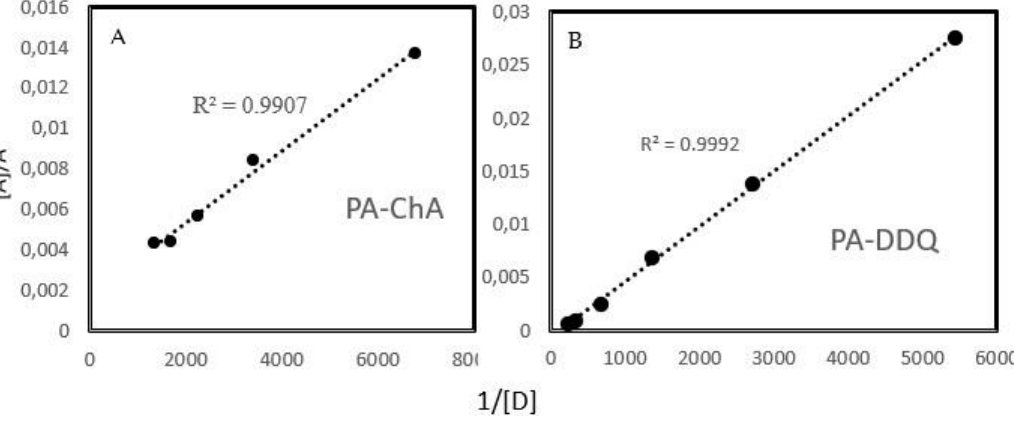
Figure 3. Spectrophotometric titration curves of A PA-ChA and B PA-DDQ CT complexes in acetonitrile at the detectable peaks (donor and acceptor, 1 × 10 −3 M).